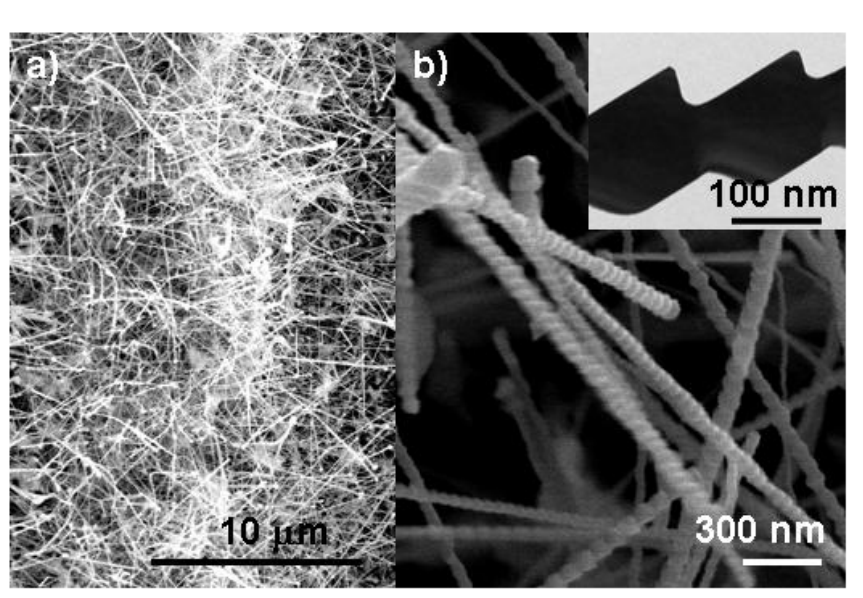
Figure 14. The SEM images of single crystalline Zn